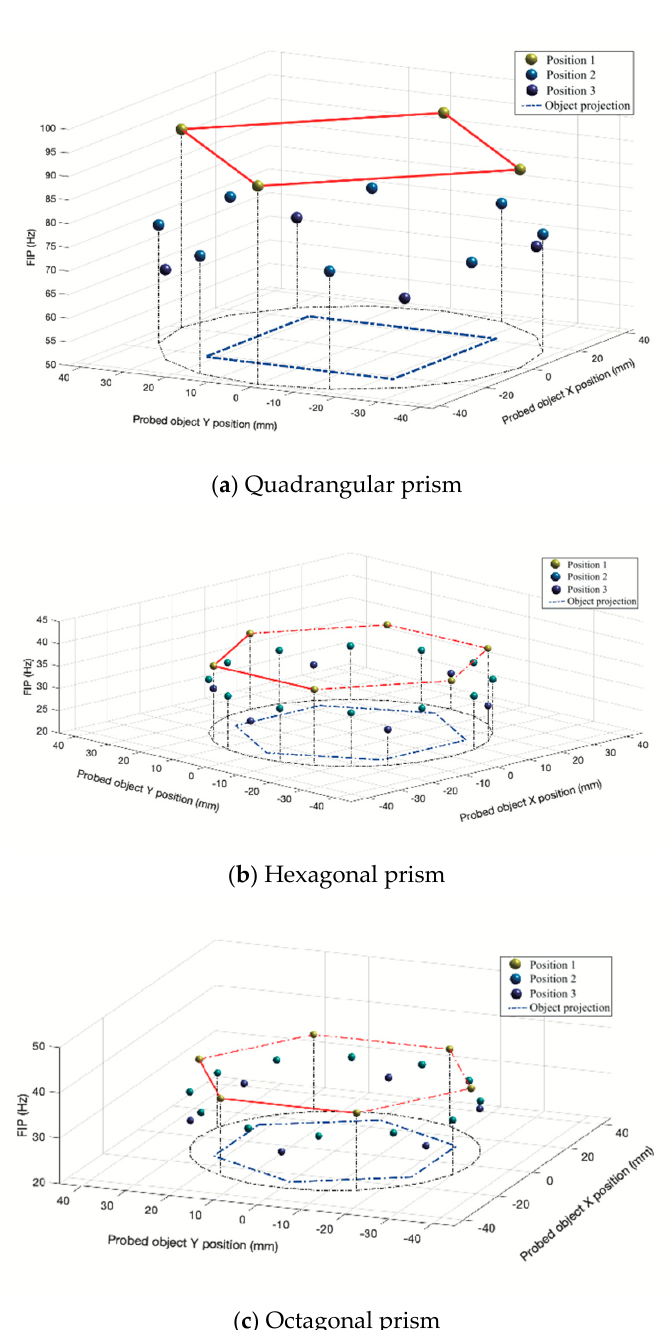
Figure 12. Three − dimensional spatial distribution of FIP for different geometries.